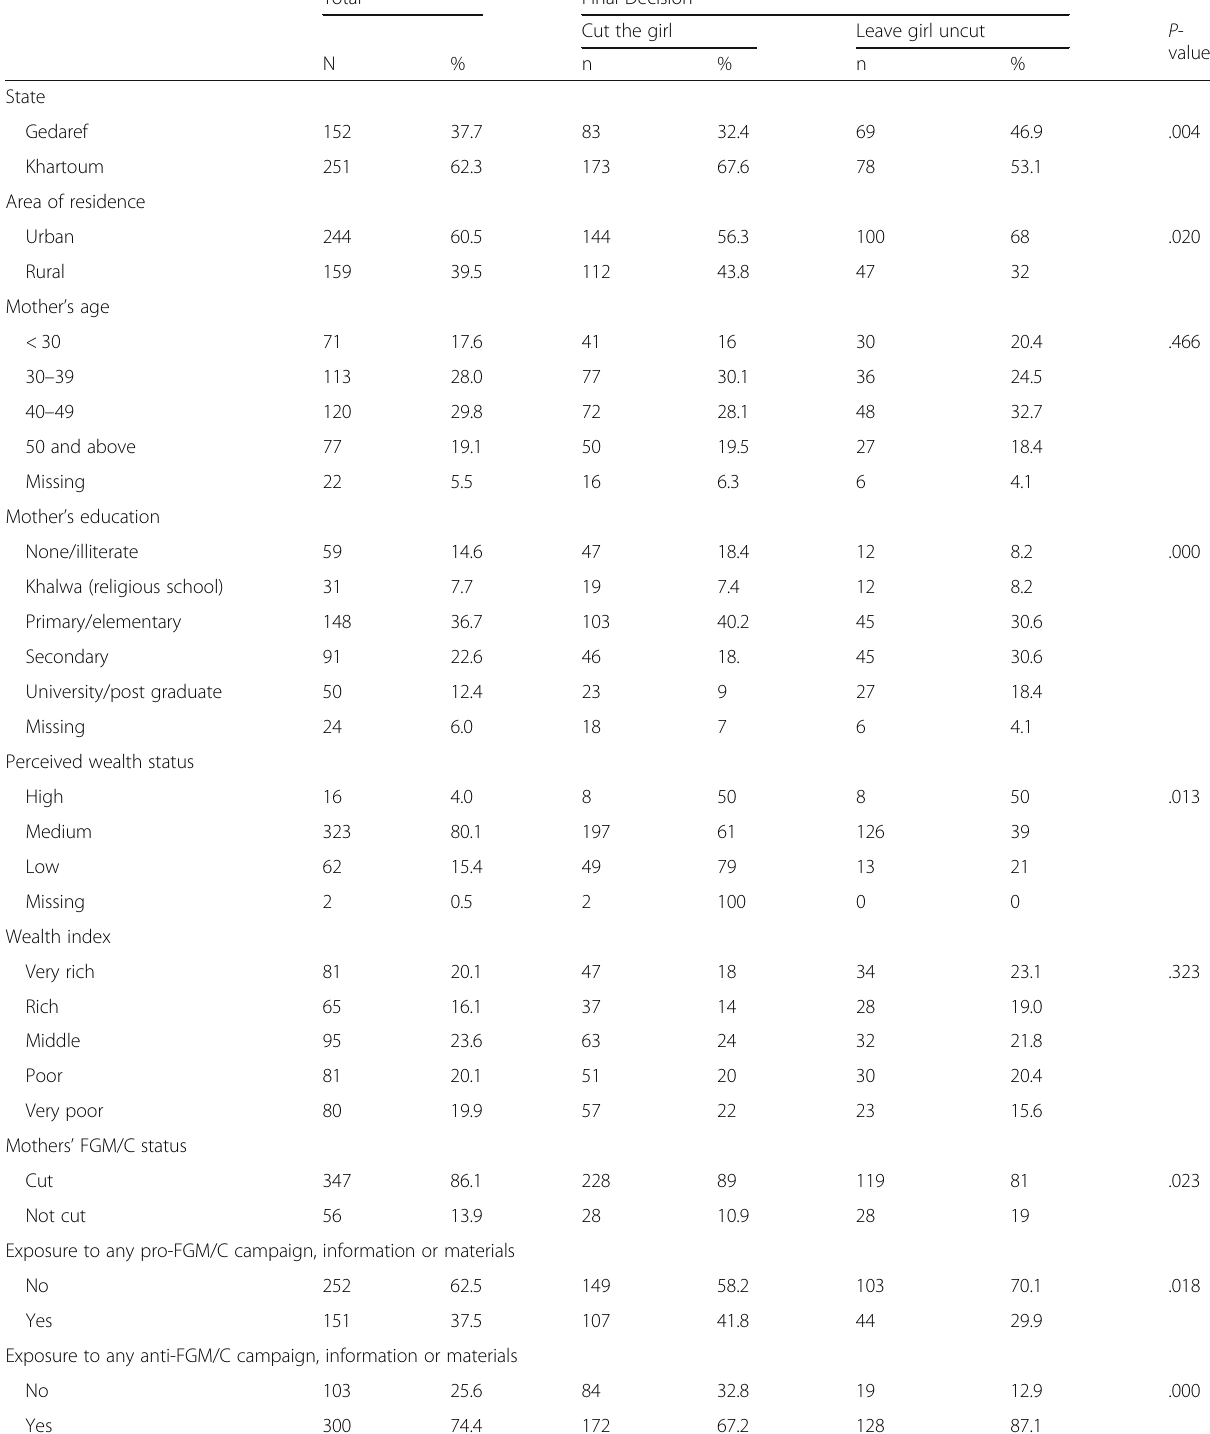
Table 1 Households ’ characteristics and bivariate associations with FGM/C final decision ( N = 403) Total Final Decision Cut the girl Leave girl